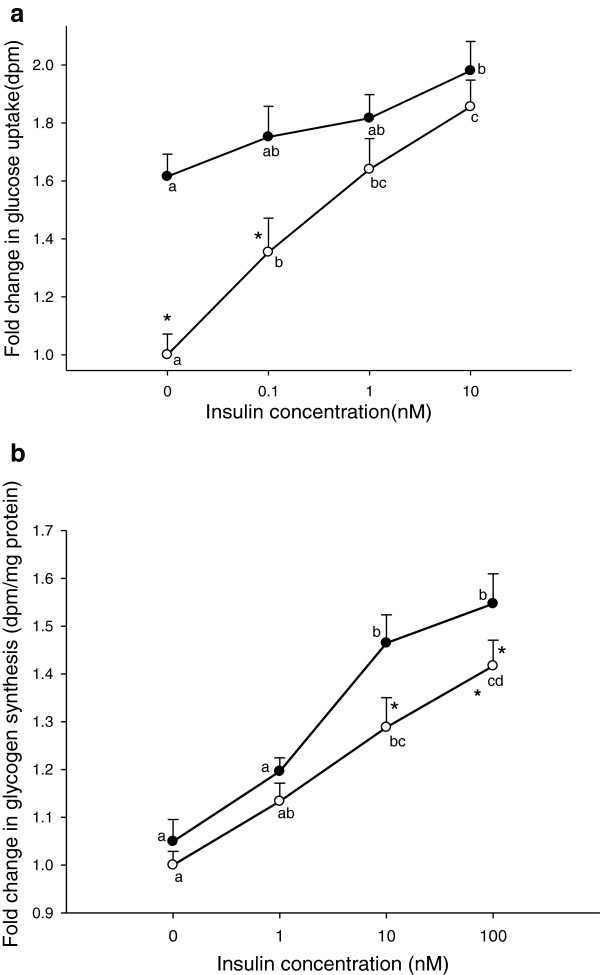
Glucose uptake and glycogen synthesis with or without PA as a function of insulin. Glucose uptake (a) was carried out on differentiated myotubes that had been incubated with (full circles) or without (open circles) 10 μM PA for 4 h, followed by different concentrations of insulin during the last 1 h. Glycogen syntheses (b) were performed on myotubes treated with (full circles) or without (open circles) 10 μM PA for 4 h, followed by 0–100 nM insulin for 2 h. Control samples lacked PA and insulin. Data are expressed as LSmean values collected from three-four wells, carried out in three separate experiments with cells isolated from a different pig each time. LSmeans with different letters (a-d) denote significantly different responses related to the insulin concentration, while * denotes LSmeans with significantly different responses with or without PA; (P < 0.05).